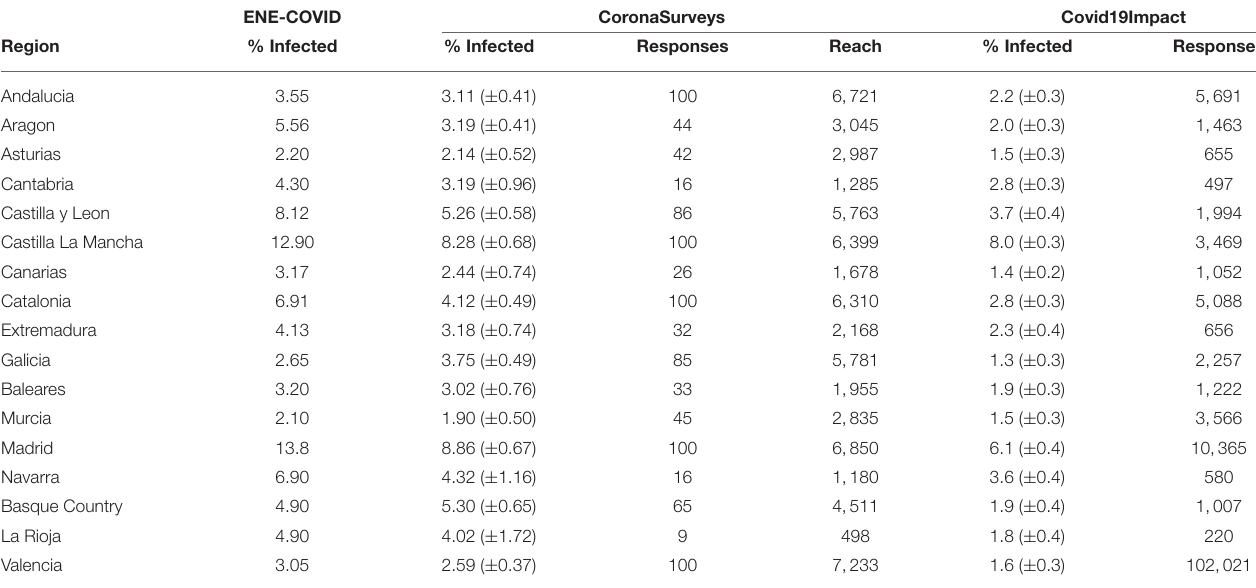
TABLE 1 | Percentage (and 95 % confidence interval) of infected population per region according to the ENE-COVID serology study (14), CoronaSurveys, and Covid19Impact ( 11) (symptom-only model).